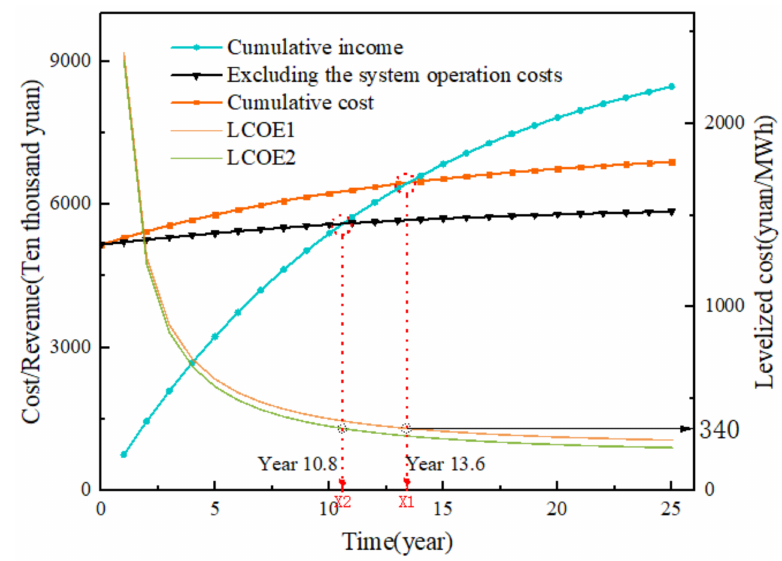
Figure 5. Investment payback period and LCOE